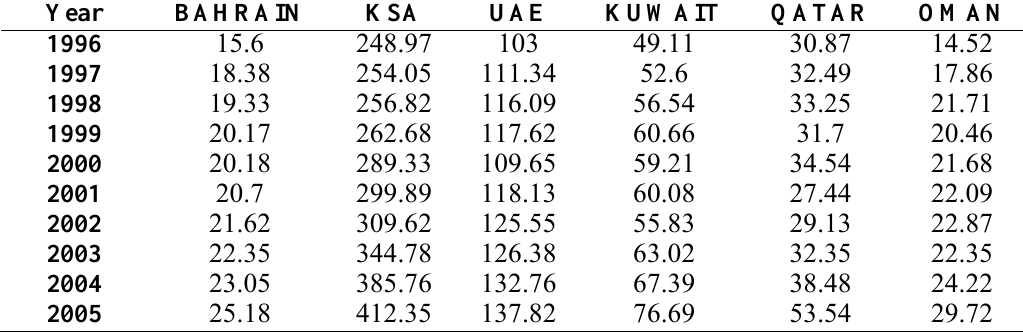
Table1. CO GHG Emissions for the GCC (million metric 2